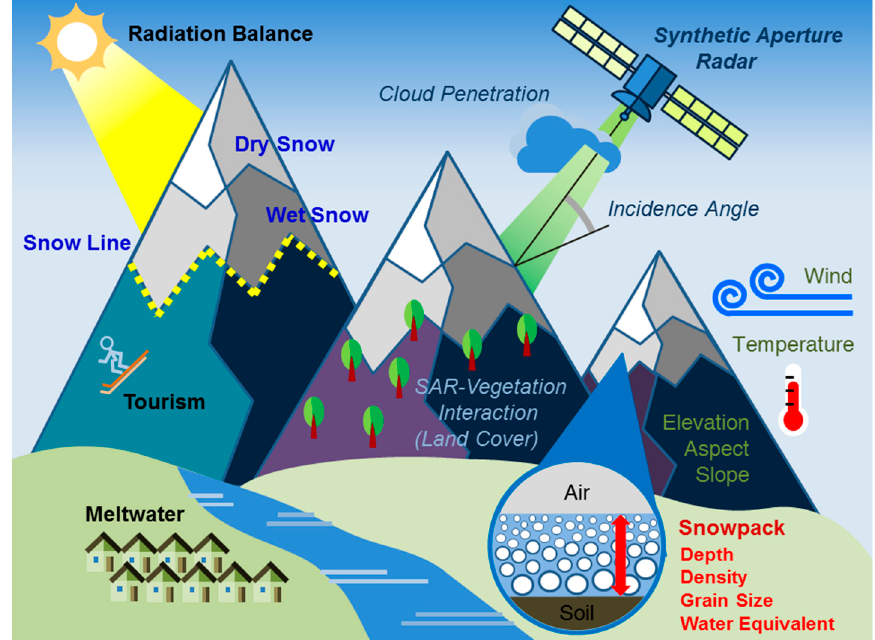
Figure 1. Illustration of different snow types and snow line (deep blue font), the importance of snow (black font), synthetic aperture radar (SAR)-related characteristics (font in italics), factors influence snow (green font) and snowpack parameters (red font).